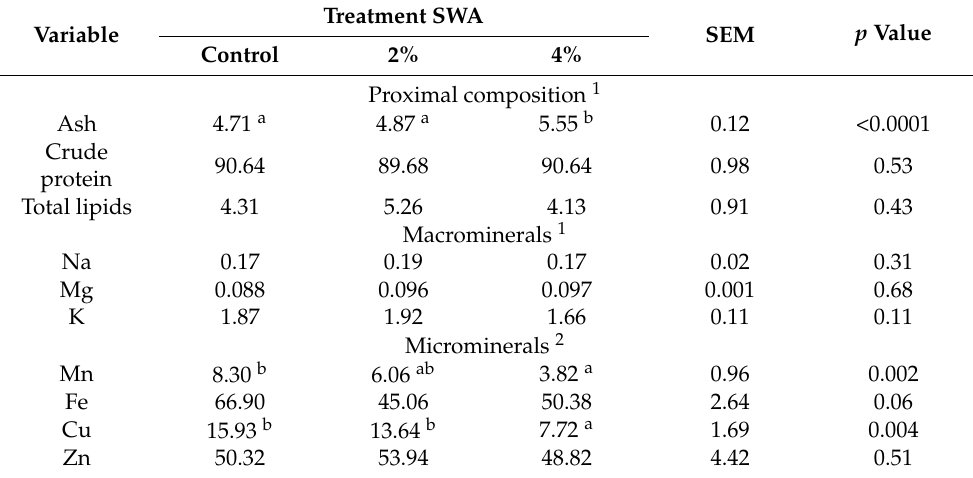
Table 5. Means of proximate composition and mineral content based on dry matter (DM) by treatments.